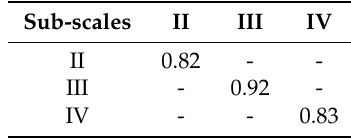
Table 5. Test–retest correlations for